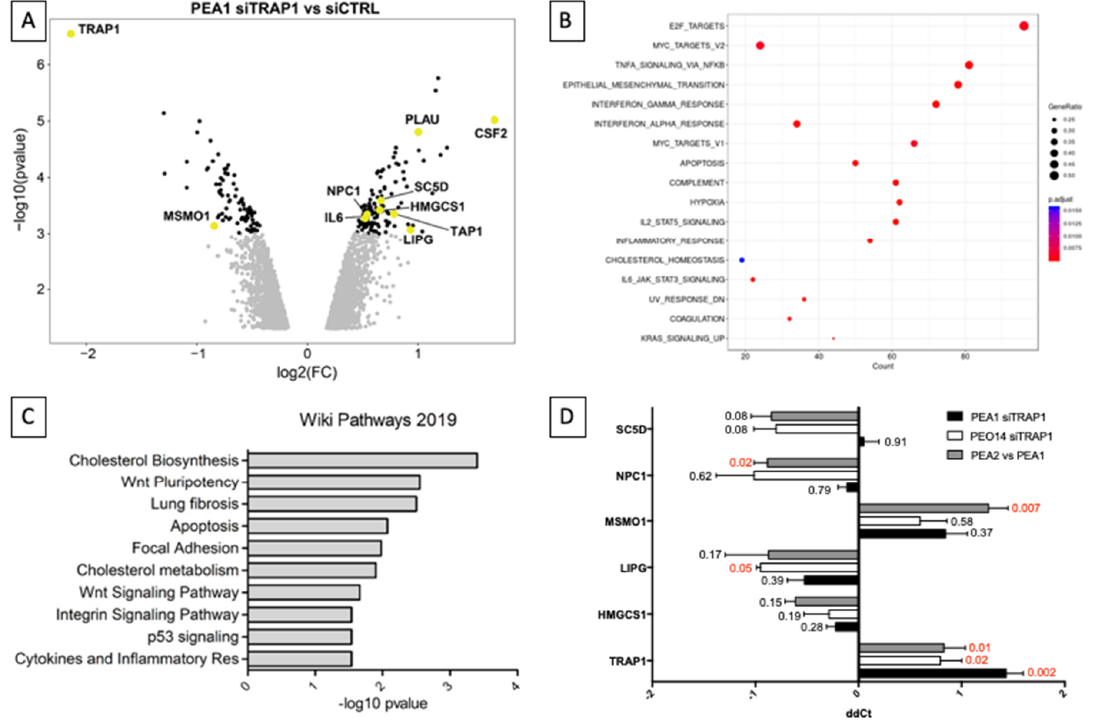
Figure 1. TRAP1 expression modulates genes involved in inflammation and lipid homeostasis. ( a ) Volcano plot showing the whole genome gene expression changes in PEA1 cells upon siRNA-mediated TRAP1 silencing (black = p < 0.001, light gray = p < 0.01). Relevant transcripts are highlighted, chosen for belonging to the cholesterol pathway or the inflammatory response. ( b ) Dot-plot representing hallmarks emerging from gene set enrichment analysis of the di ff erentially expressed genes upon siRNA-mediated TRAP1 silencing in PEA1 cells. ( c ) Gene set enrichment analysis on the list of genes significantly modulated in expression ( p < 0.001) upon TRAP1 silencing in PEA1 cells as for the microarray analysis. ( d ) Real-time RT-PCR analysis of genes involved in the cholesterol metabolic pathway found di ff erentially expressed upon TRAP1 silencing in PEA1 cells according to microarray analyses. PEA1 and PEO14 cells were transfected with nontargeting control siRNA or TRAP1-directed siRNA (siTRAP1) and collected 72 h after transfection. All data are expressed as mean ± standard error of the mean (S.E.M.) of delta-delta Ct (ddCt) from six (PEA1 siTRAP1), three (PEO14 siTRAP1), or four (PEA2 vs. PEA1) independent experiments with technical triplicates each. Numbers indicate the statistical significance ( p -value), based on the Student’s t -test (significant values highlighted in